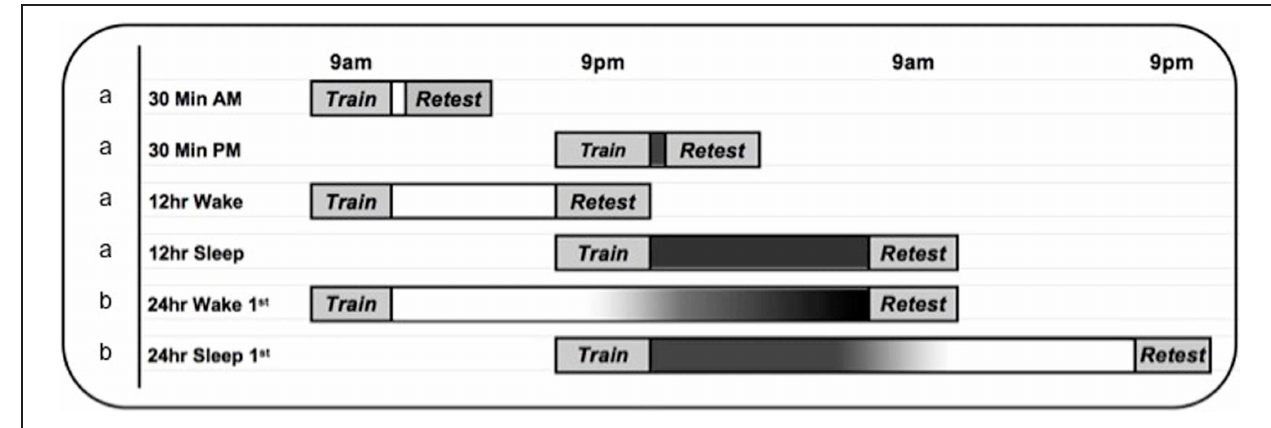
FIGURE 1 | Experimental timeline. The 30min ( n = 40), 12h wake ( n = 24) and 12h sleep ( n = 24) groups (labeled “a”) are from Payne et al. (2008). Note: Because there were no differences in performance in the 30min groups (30min am, n = 20 and 30min pm, n = 20), they were combined into a single 30min variable for analyses reported in the current paper. The